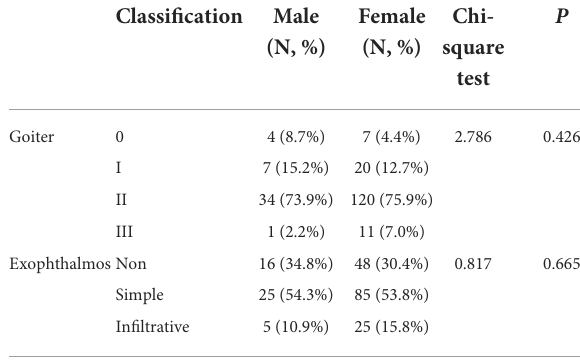
TABLE 3 Goiter and exophthalmos between different